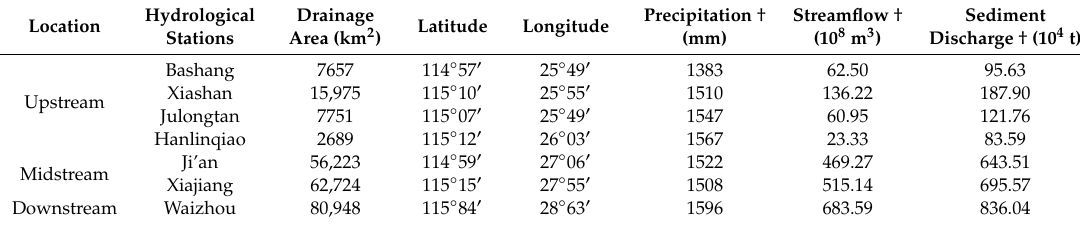
Table 1. Hydrological stations on the Gangjiang River